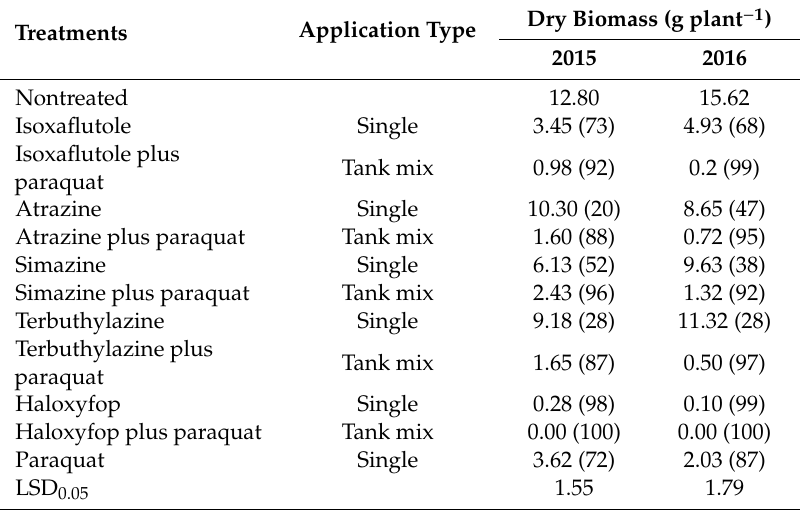
Table 5. E ff ect of single and tank mixture herbicide treatments on weed biomass at 42 d after treatment of flowering Chloris virgata in pots over two separate experiments conducted in 2015 and